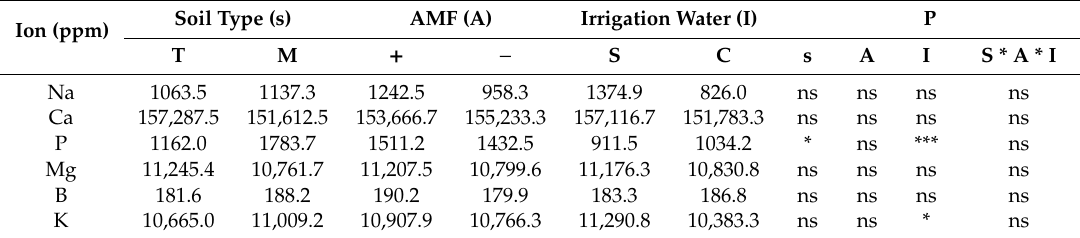
Table 2. Soil mineral content according to soil type (s) (traditional: T and mixed: M), AMF inoculation (A) (with: + or without: − ), irrigation water (I) (saline: S, control: C), and interaction among them. Statistical significance according to one-way and three-way ANOVA tests. Values are means of three samples.